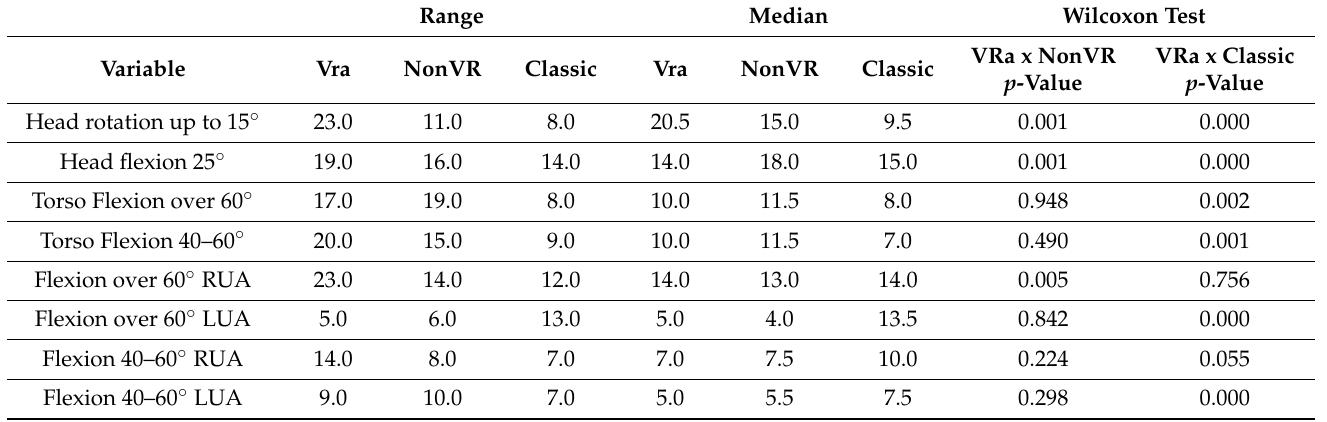
Table 3. Wilcoxon paired